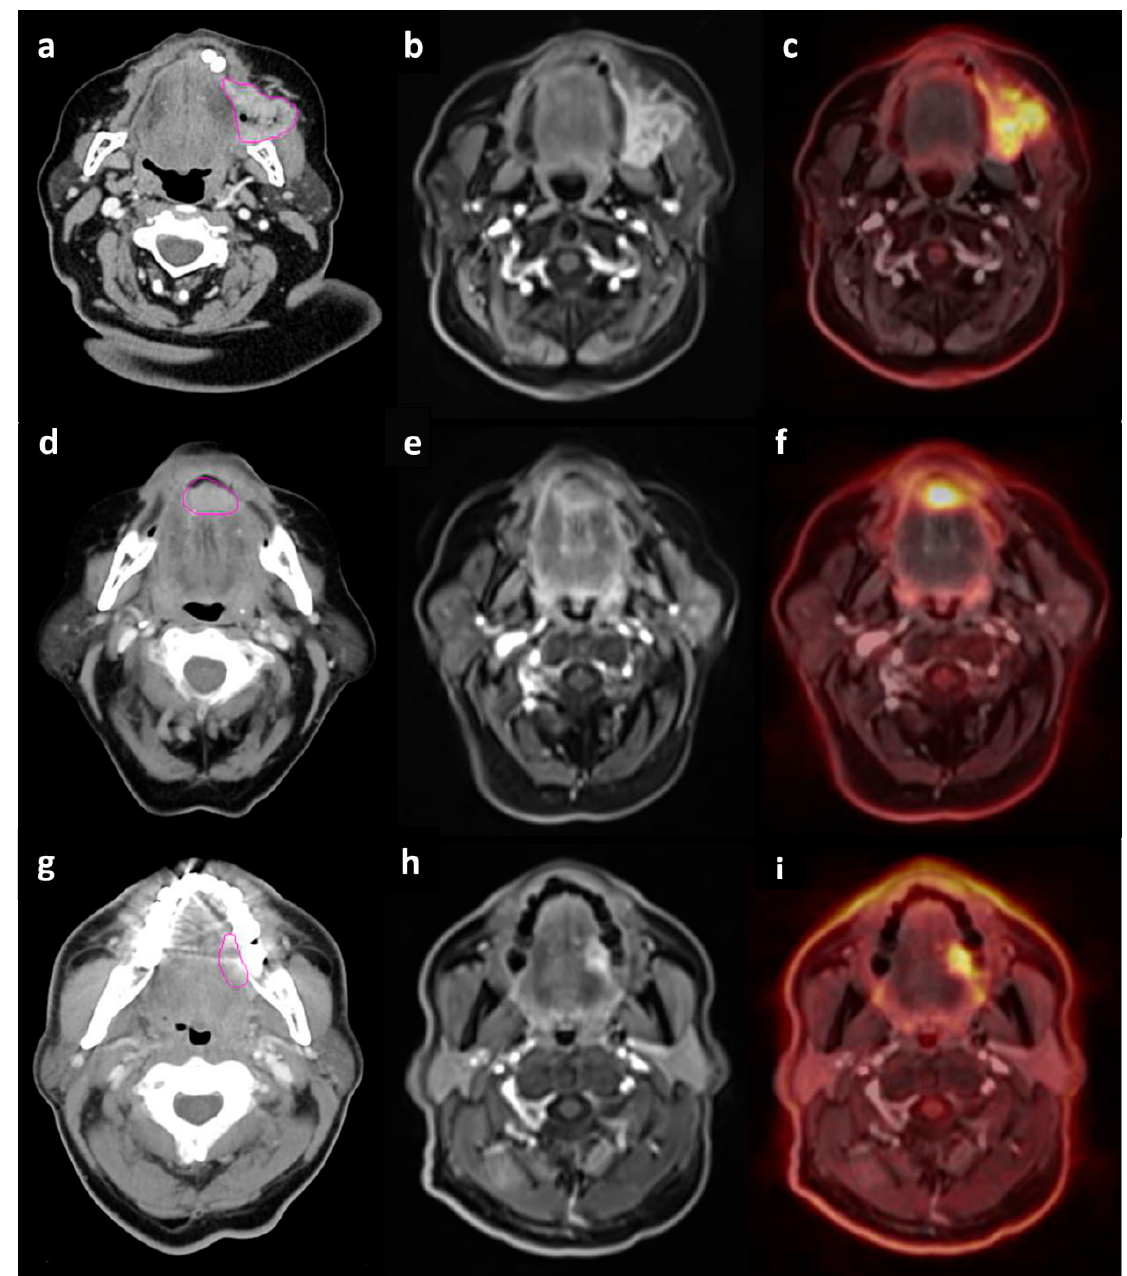
Figure 2. Contrast enhancement computed tomography (CT) ( a , d , g ), T1-weighted volumetric interpolated breath hold examination (VIBE) magnetic resonance (MR) ( b , e , h ) and positron emission tomography/MR (PET/MR) ( c , f , i ) imaging of head and neck cancer patients. ( a , b , c )—patient with squamous cell carcinoma of the buccal mucosa in clinical stage T3N2b; ( d , e , f )—patient with squamous cell carcinoma of the floor of the mouth in clinical stage T1N0; ( g , h , i )—patient with squamous cell carcinoma of the oral tongue in clinical stage T2N0.